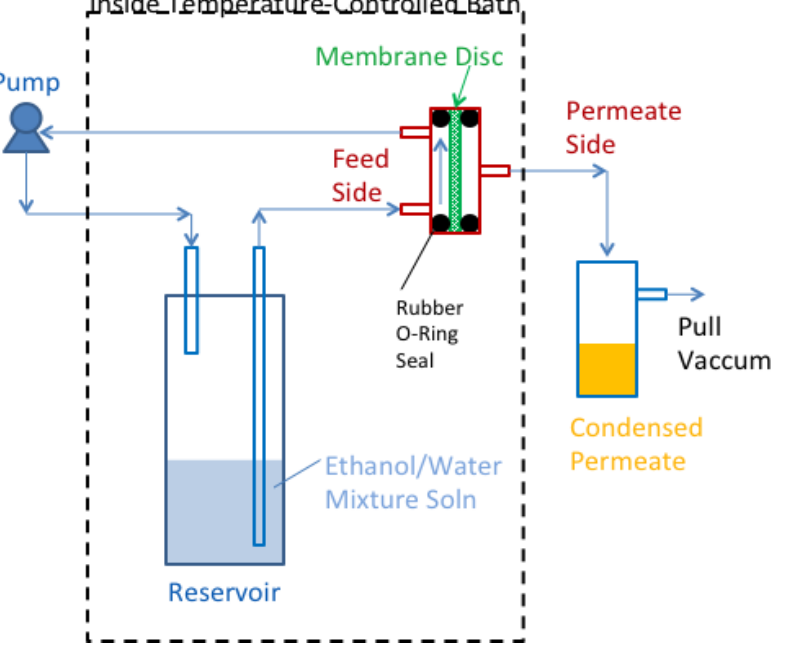
Figure 2. Liquid-phase separation of an ethanol–water solution with a superhydrophobic HiPAS membrane (“Baseline Disc” and “SO Disc”). Schematic for the cross-flow pervaporation separation test setup.